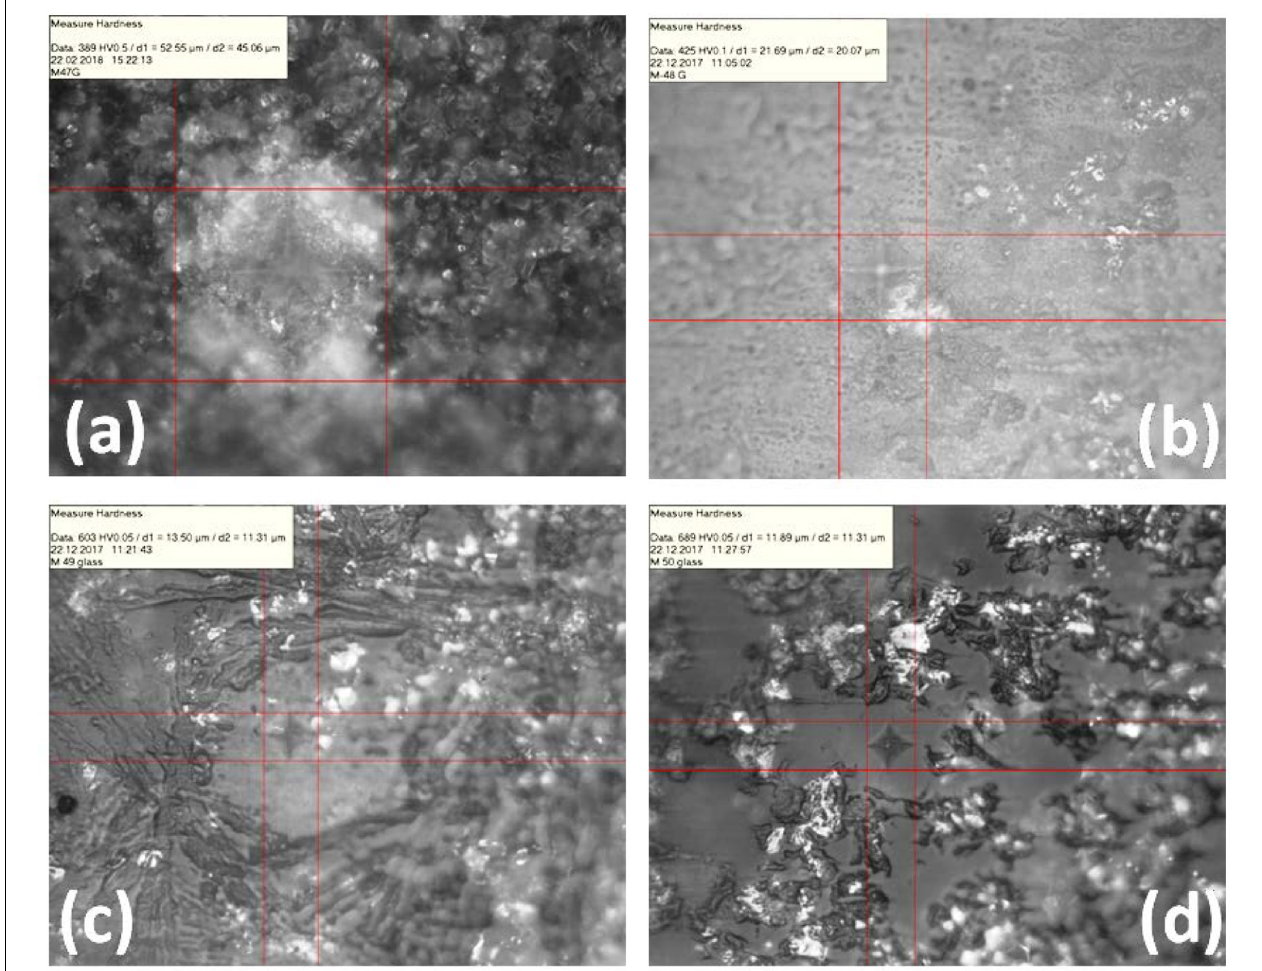
FIGURE 10 | Photograph of micro-hardness indentation impression on K 2 O-MgO-Al 2 O 3 -B 2 O 3 -SiO 2 -F glasses (A) Cr-0, (B) Cr-2, (C) Cr-4, and (D) Cr-7, showing the increasing crystallinity with chromium content (for composition see Table 1 ).